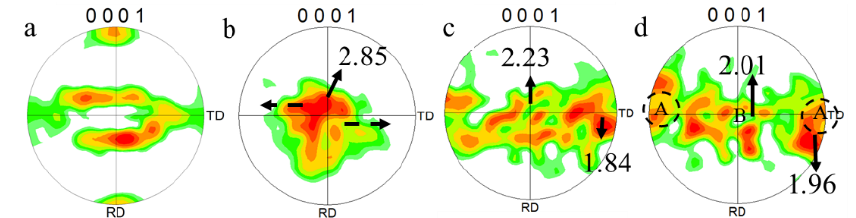
Figure 10. Pole figures (PFs) at various deformation positions at 760 °C: ( a ) at the grip position, ( b ) the gauge section near the grip, ( c ) the middle of the gauge section, and ( d ) section near the tip of the fracture.